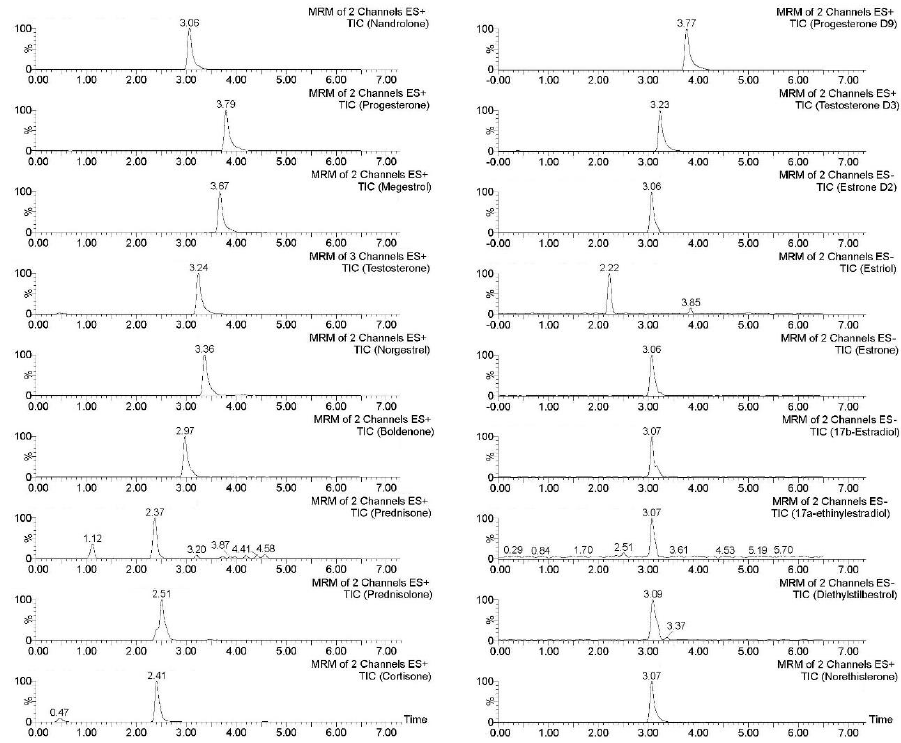
Figure 5. Chromatogram of a skimmed milk sample spiked with 100 ng · mL − 1 of each of the selected hormones obtained after the application of the optimized FPSE–UHPLC–MS/MS methodology.